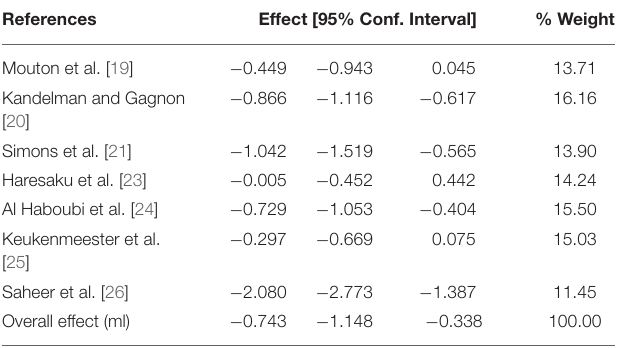
TABLE 5 | Meta-analysis of Xylitol SFG and plaque quantity using the random-effects model by date of